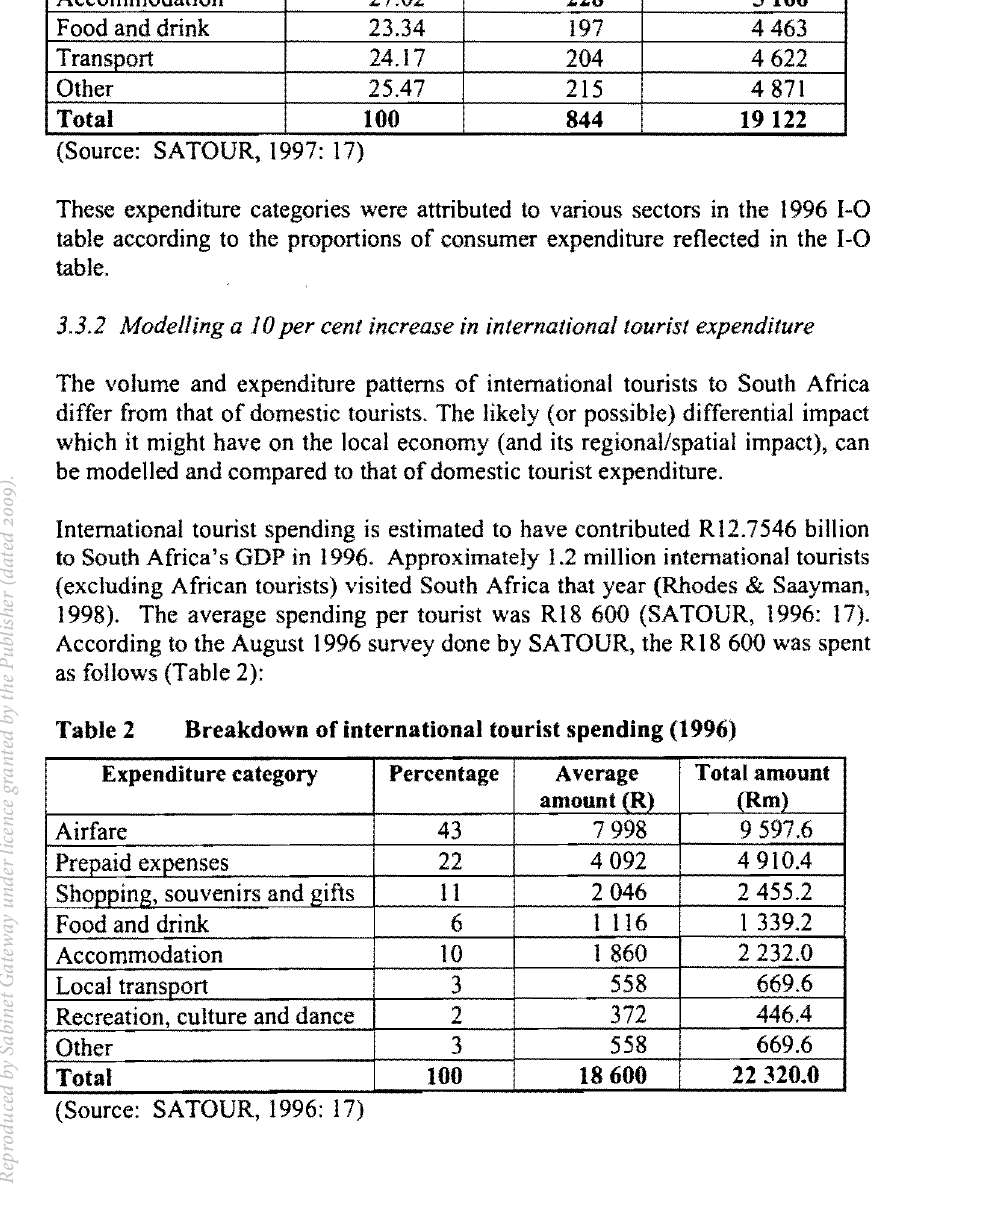
Breakdown of domestic tourist spending (1996) Expenditure category